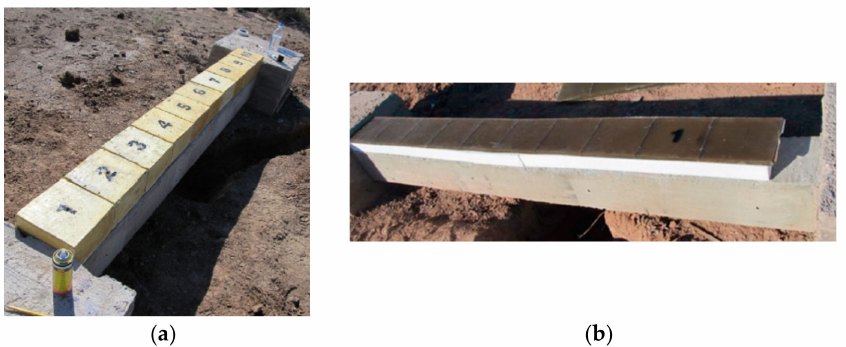
Figure 12. RC columns reinforced with: ( a ) polyurethane bricks [15,16] and ( b ) resin panels and insulation layer [22]. Copyright permission obtained from authors.